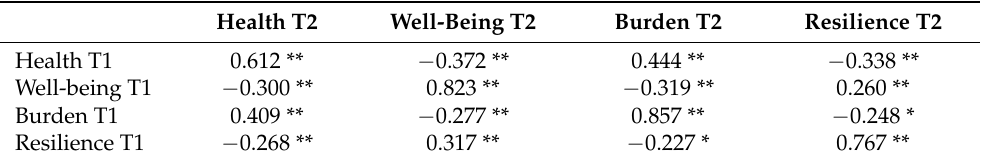
Table 4. Analysis of correlations between age, health, well-being, overload and resilience between pre-test (T1) and post-test